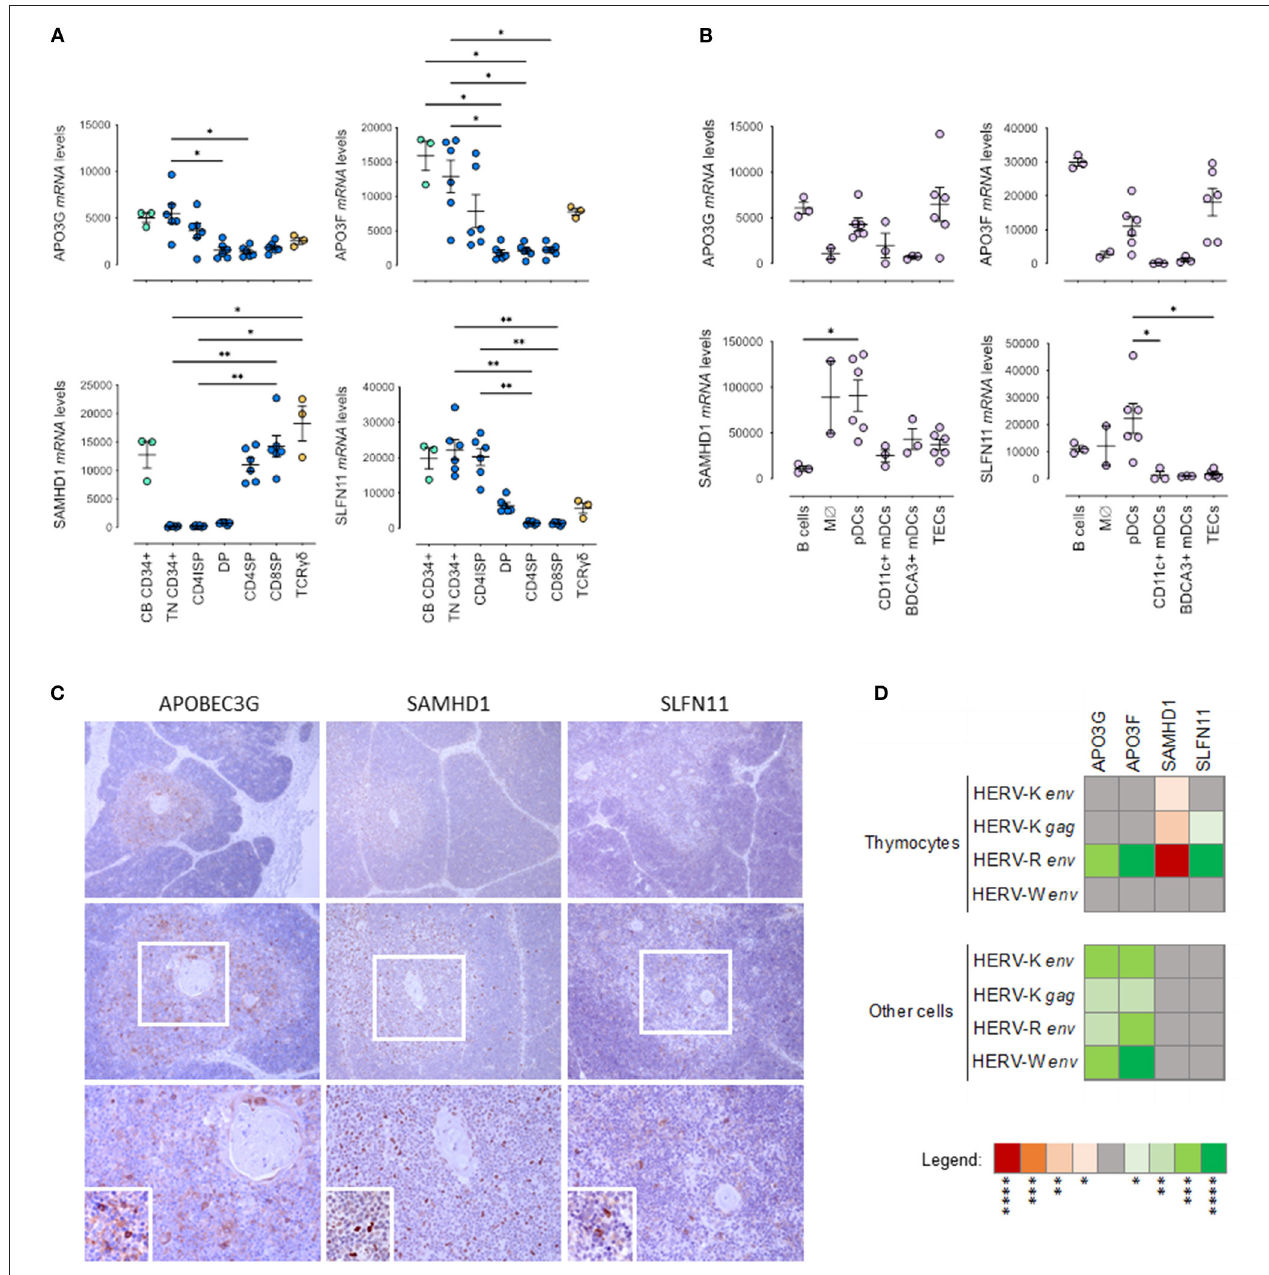
FIGURE 2 | Host Restriction Factor (HRF) expression in pediatric thymuses. Relative transcriptional levels of the host restriction factors APOBEC3G, APOBEC3F, SAMHD1 and SLFN11 normalized to β -actin expression levels in sort-purified: (A) CD34 + cells from cord blood, thymocyte subsets along T cell development (TN, Triple Negative; CD4ISP, Immature Single Positive CD4; DP, Double Positive; CD4SP, CD4 Single Positive and CD8SP, CD8 Single Positive) and γ δ thymocytes; (B) Major non-T cell populations in the thymus, namely B cells, monocytes/macrophages (M φ ), plasmacytoid dendritic cells (pDCs), both CD11c + and BDCA3 + myeloid dendritic cells (DCs), and thymic epithelial cells (TECs); each dot represents one different thymus; results were compared using Kruskal-Wallis with Dunn’s multiple comparisons test; * P < 0.05; ** P < 0.001. (C) APOBEC3G, SAMHD1 and SLFN11 protein expression evaluated by immunohistochemistry in representative thymus samples; upper images amplification 100x; middle images amplification 200x; bottom images 400x - Digital zoom insert - the image down to a centered area with the same ratio as the original; Positive cells stained in brown; (D) Correlogram of the transcriptional levels of factors APOBEC3G, APOBEC3F, SAMHD1 and SLFN11 with transcriptional levels of HERV-K, -W, and -R env in total thymocytes and in the other cells from the thymus, using non-parametric Spearman correlation test (red/negative and green/positive) . *p < 0.05; ** p < 0.01; *** p < 0.001; **** p < 0.0001.